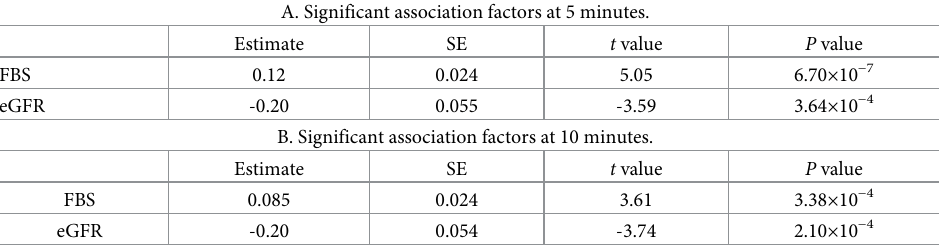
Table 2. Results of stepwise multiple regression analysis for a systolic blood pressure. Explanatory variables including age, gender, BMI, FBS, eGFR, pre-operative SBP/DBP and PR, the presence or absence of DM and the pres- ence or absence of hypertension